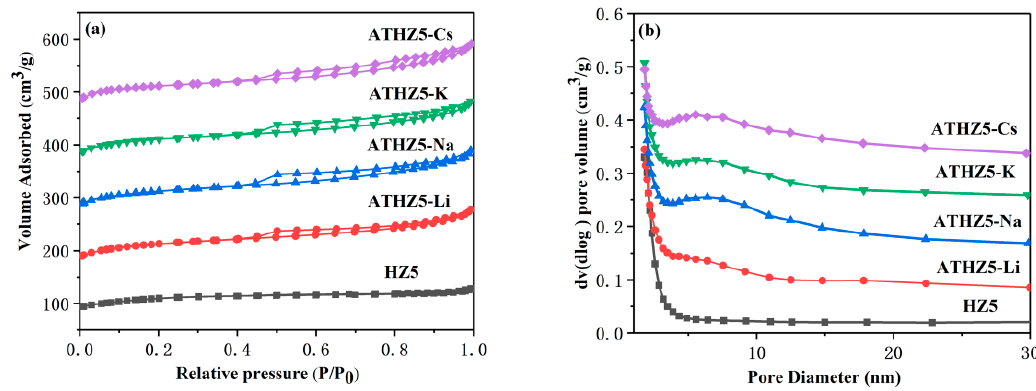
Figure 2. ( a ) Nitrogen adsorption–desorption isotherms and ( b ) Pore size distributions of HZ5 catalyst and modified catalysts.